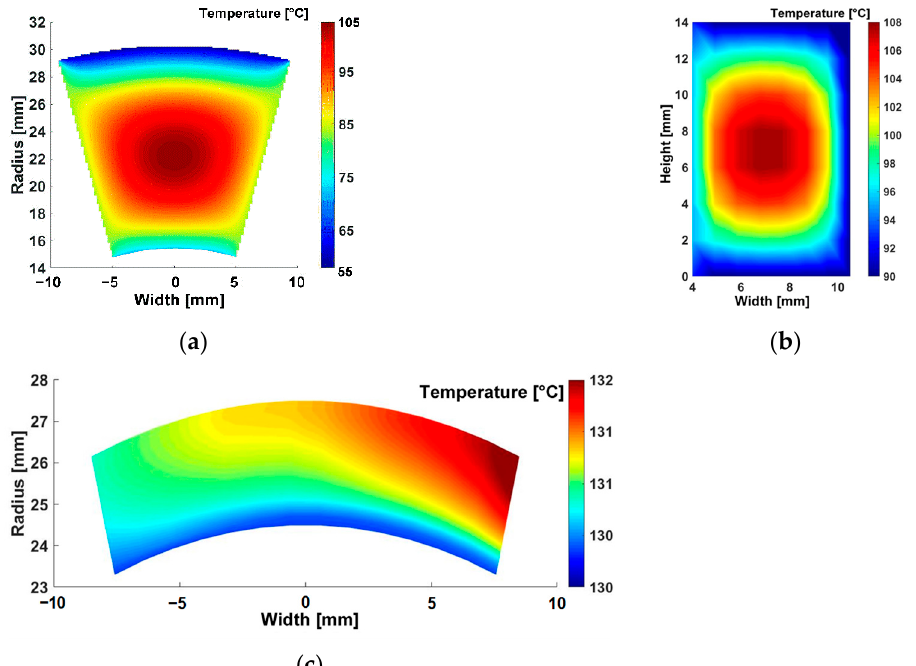
Figure 38. Transient temperature distributions predicted by SDTMs at 20 min [85] based on a 12-slot/10-pole SPMSM. ( a ) Active-winding (6.8 Nm at 600 r/min). ( b ) End-winding (6.8 Nm at 600 r/min). ( c ) PM (4.8 Nm at 7200 r/min).